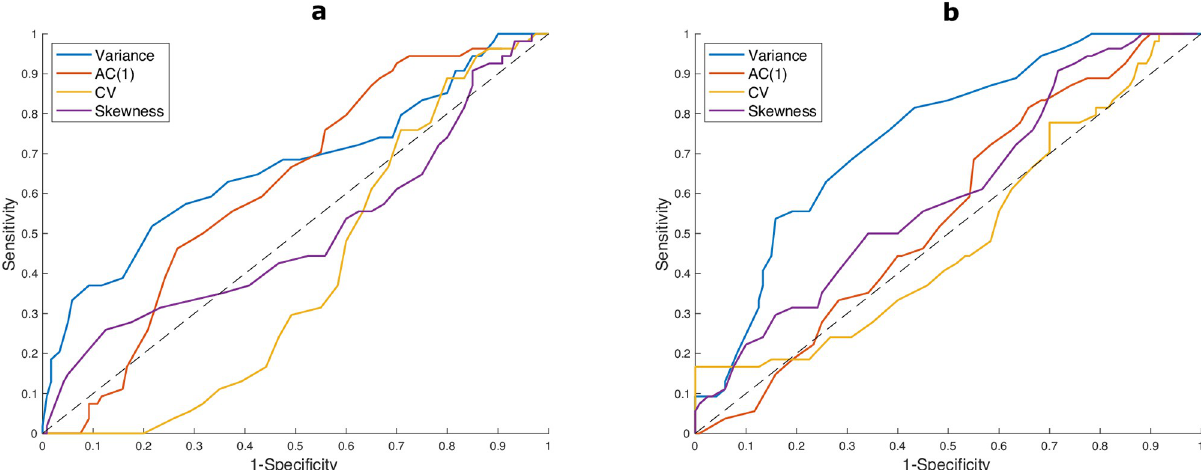
Fig 5. ROC curves for each considered indicator, with sensitivity and specificity calculated on each timepoint for all countries in Y . Each point corresponds to a test value for τ , to define if the detection is positive. The diagonal line corresponds to the ROC of a random classifier. Curves above it imply better performance. a) Computed on Gaussian filtered data; b) Computed on ARIMA detrended data.